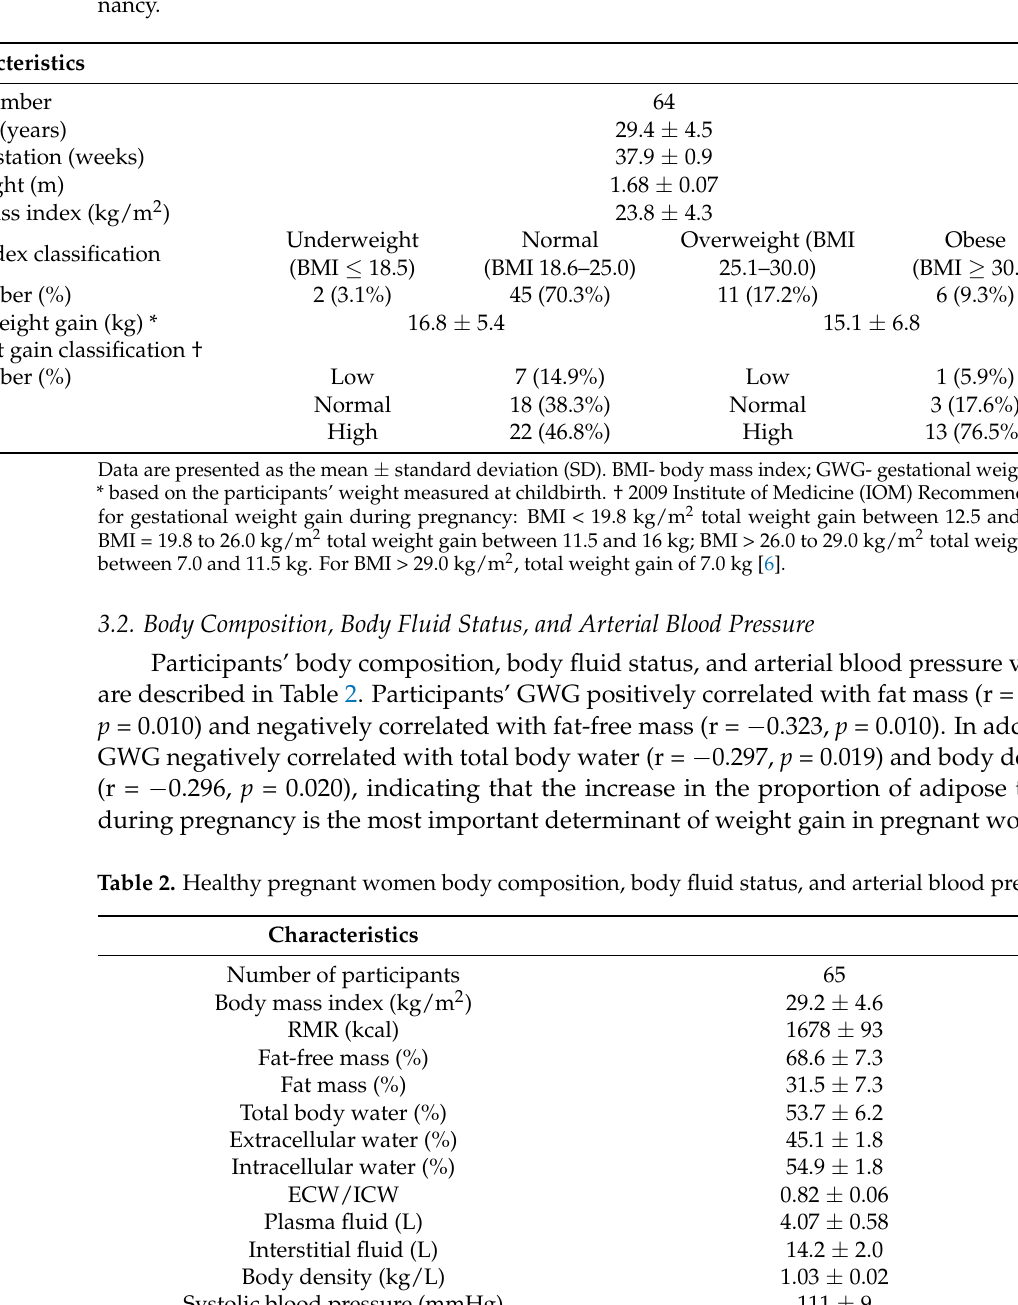
Table 1. Participants’ characteristics, initial body mass index (BMI), and weight gain during preg- nancy.